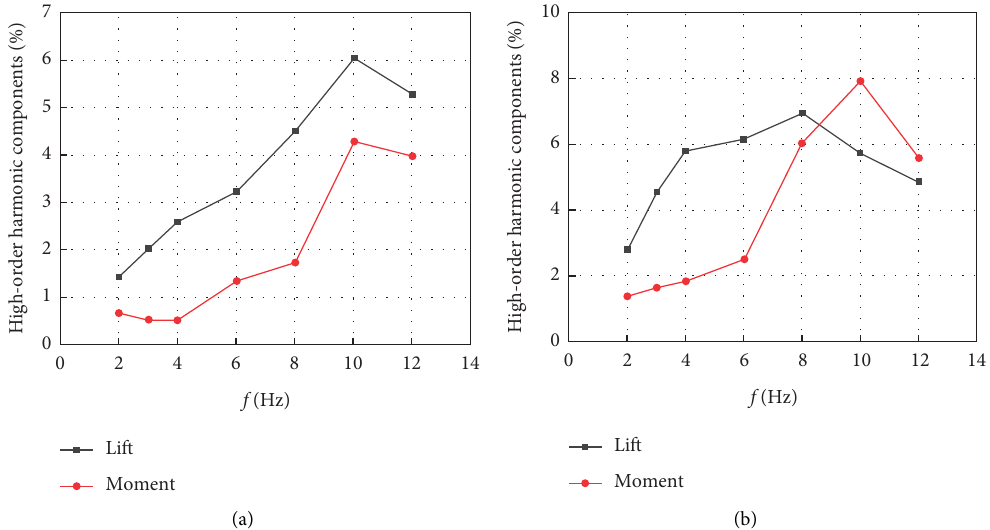
Figure 16: Proportion of high-order harmonics under single degree-of-freedom vibration. (a) Heaving motion. (b) Pitching motion.